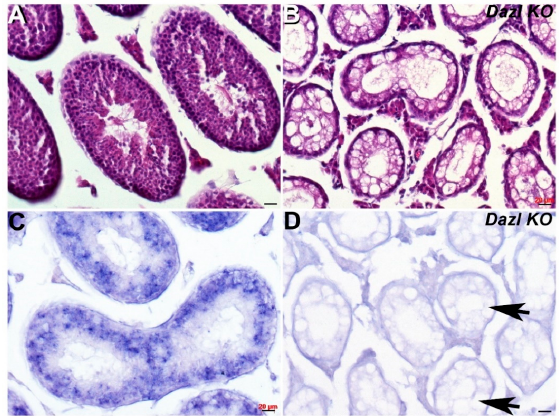
Figure 3. Spatiotemporal analysis of Cracd expression in Dazl KO testis. ( A , B ) Hematoxylin and eosin staining of P29 wildtype ( A ) and Dazl knockout ( B ) littermate testis, revealing numerous vacuoles (arrows, D ) and the absence of any germ cells in Dazl null testis. Non-radioactive in situ hybridization detection of Cracd mRNA in P29 wildtype ( C ) and Dazl knockout ( D ) testis. Note, complete absence of Cracd in Dazl null testis but robust mRNA in wildtype control littermate. Scale bars = all 20 μ m.